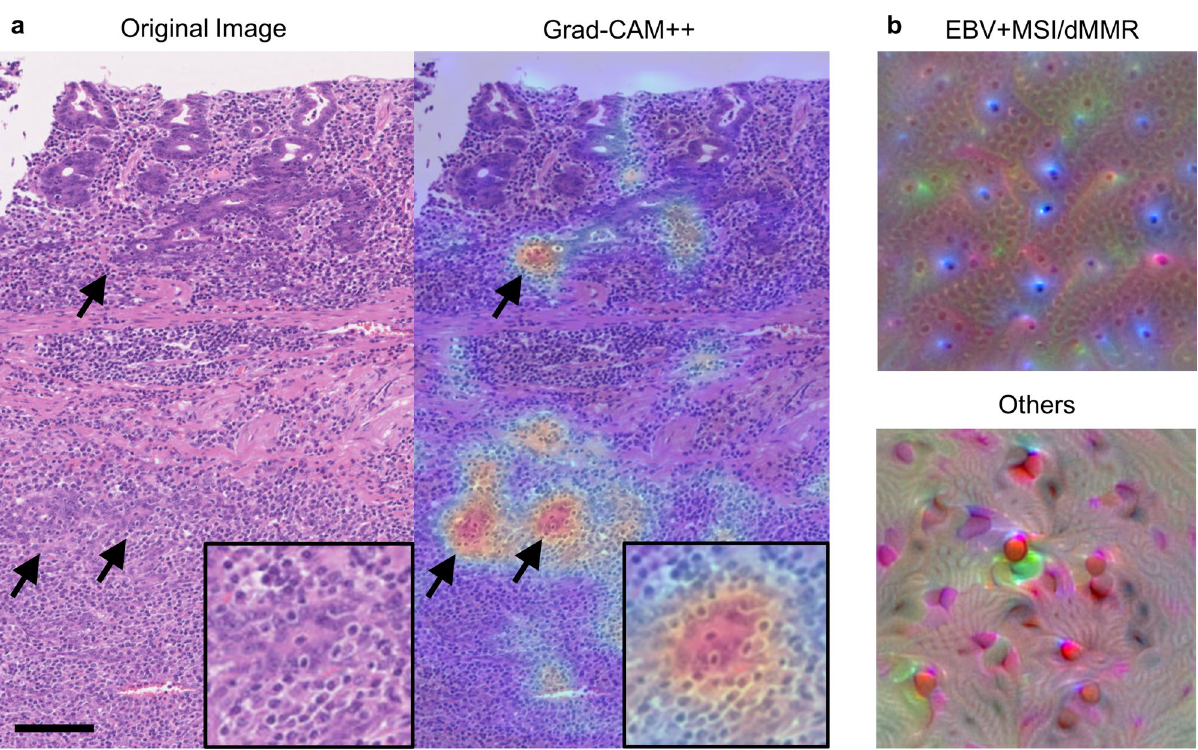
Figure 4. Visualization of the trained network. ( a ) An example of applying Grad- CAM++ to an H&E image (left) of an EBV gastric cancer. Grad- CAM++ (right) highlights the most discriminative area in this image to explain the decision made by the trained neural network (arrow). In a higher magnification (inset), intraepithelial lymphocytosis seems to be the most responsible focus for discriminating EBV + MSI/dMMR from others. Scale bar: 100 µm. ( b ) Created images with the highest probability to be predicted as “EBV + MSI/ dMMR” (upper) and “others” (lower) with the method of activation maximization. In the former, the created image seems to represent intraepithelial lymphocytosis. EBV- Epstein-Barr virus, Grad-CAM-gradient-weighted class activation mapping, MSI- microsatellite instability, dMMR- mismatch repair